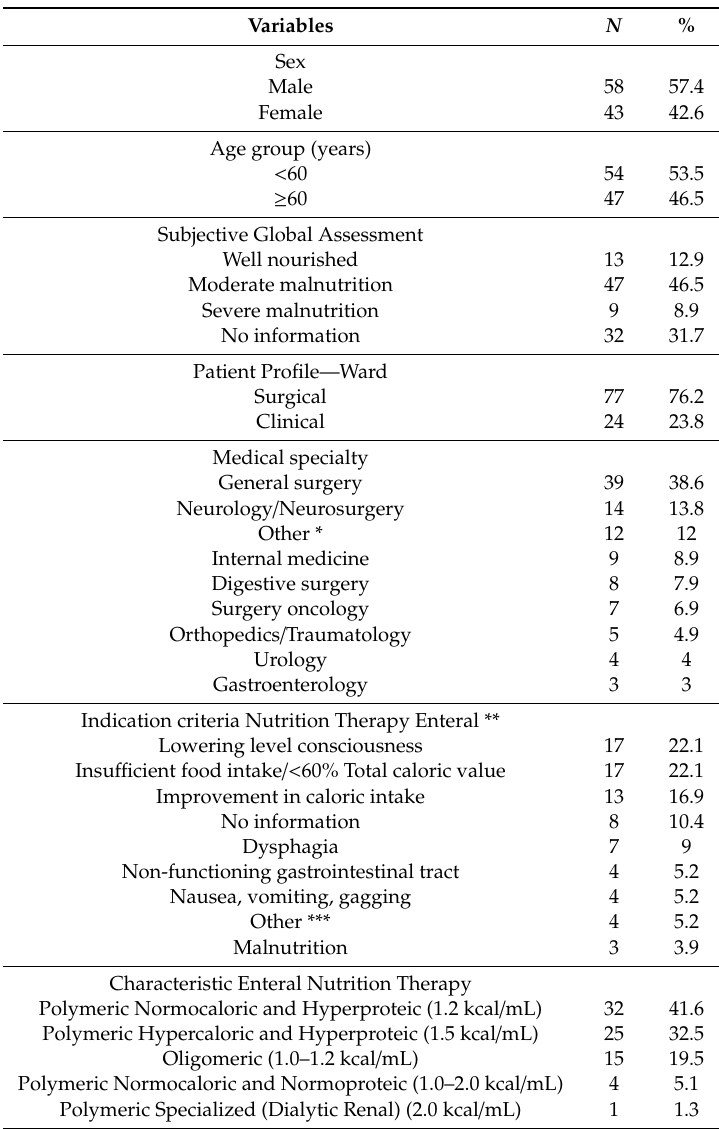
Figure 1. Nutritional support of surgical and clinical patients using Enteral Nutrition (EN), Parenteral Nutrition (PN), or the oral route (%), n = 101. Table 1. Demographic, clinical, and nutritional characterization of data from the clinical and surgical patients using enteral and parenteral nutritional therapy. ( N = 101).